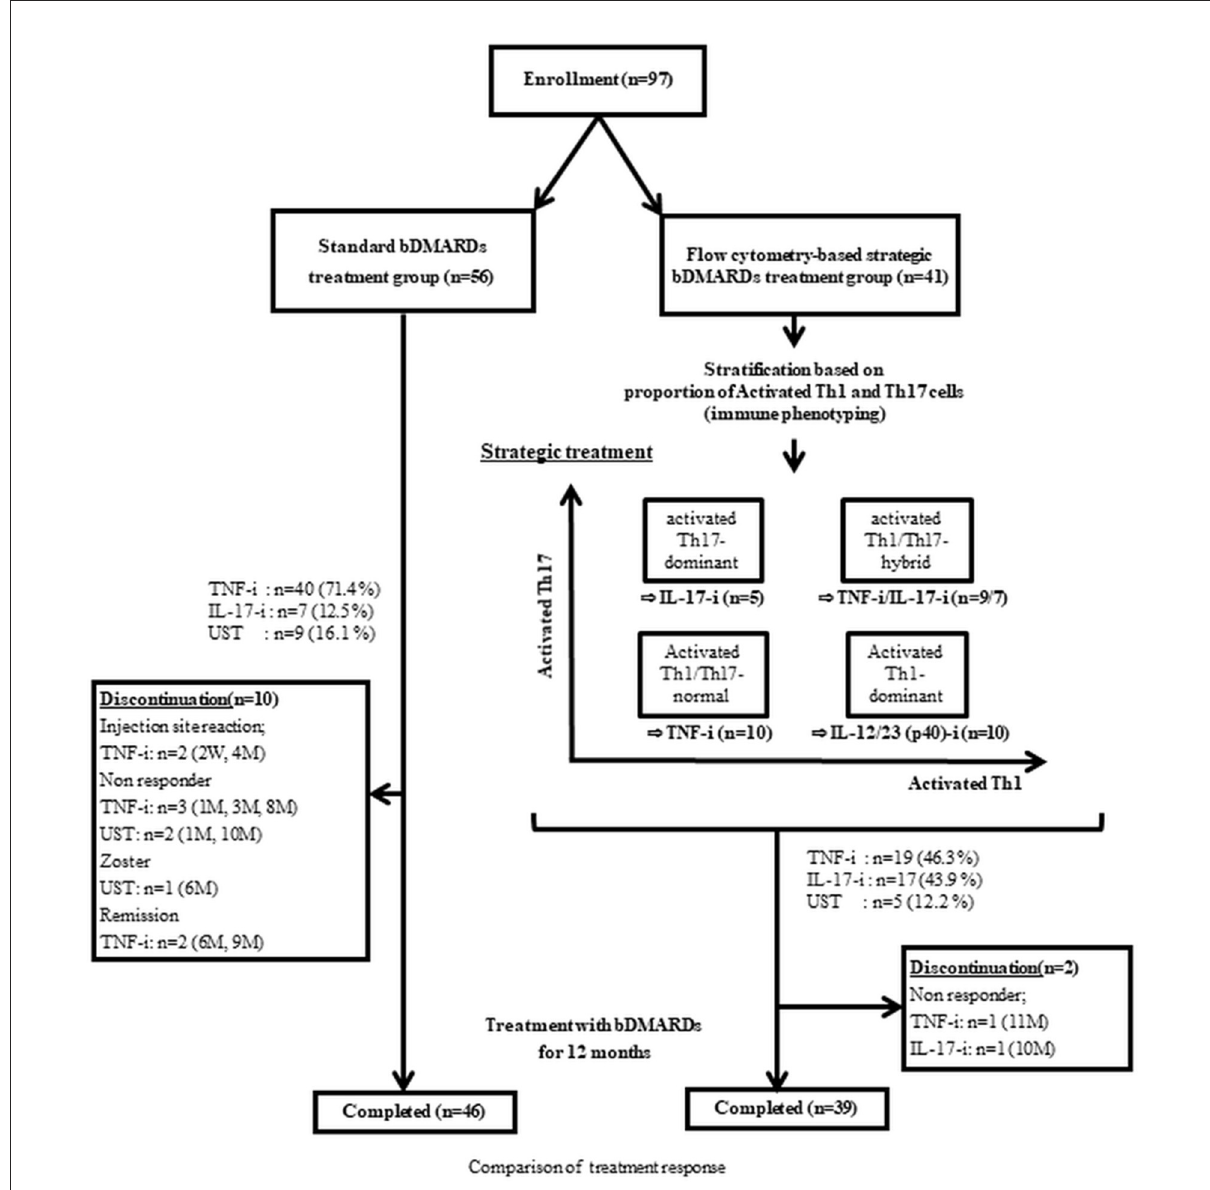
FIGURE1 Study design. UST, ustekinumab; IL-17-I, IL-17 inhibitors; TNF-I, TNF inhibitors-index; aTh1, activated Th1 cells; aTh17, activated Th17